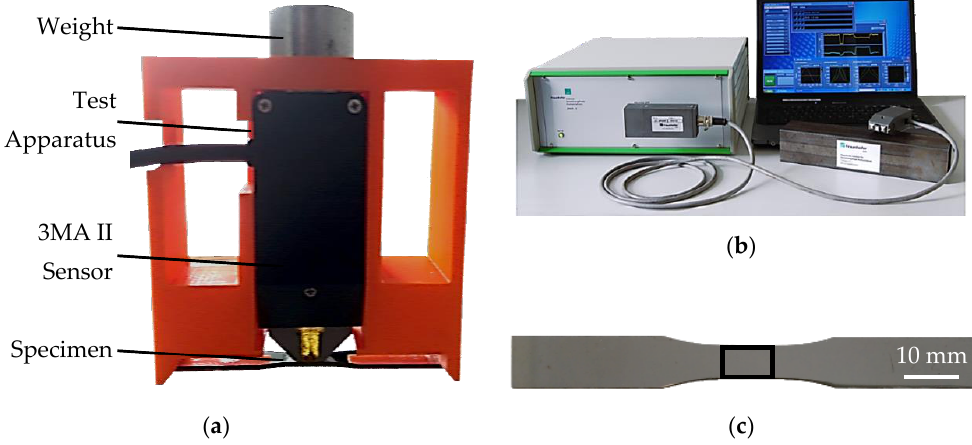
Figure 3 . Micromagnetic analysis of hot flat rolled mild steel: ( a ) measurement setup; ( b ) 3MA II device by Fraunhofer IZFP; ( c ) specimen with measurement area.